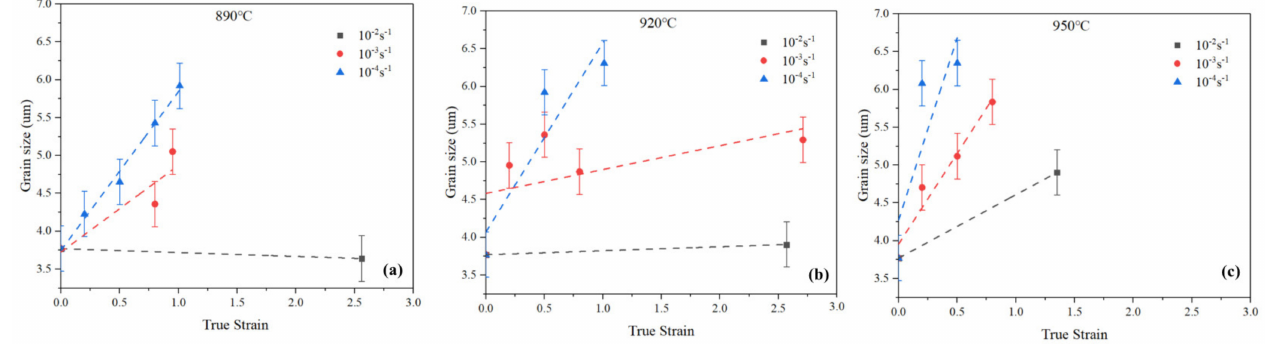
Figure 6. Grain sizes measured by EBSD observation. ( a ) 890 ◦ C, ( b ) 920 ◦ C, and ( c ) 950 ◦